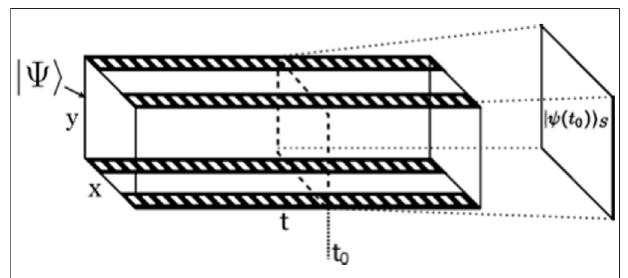
FIGURE 2 | Pictorial representation of the projection of the global state | Ψ 〉 onto a given moment of time t 0 depicted here as a strip of a movie